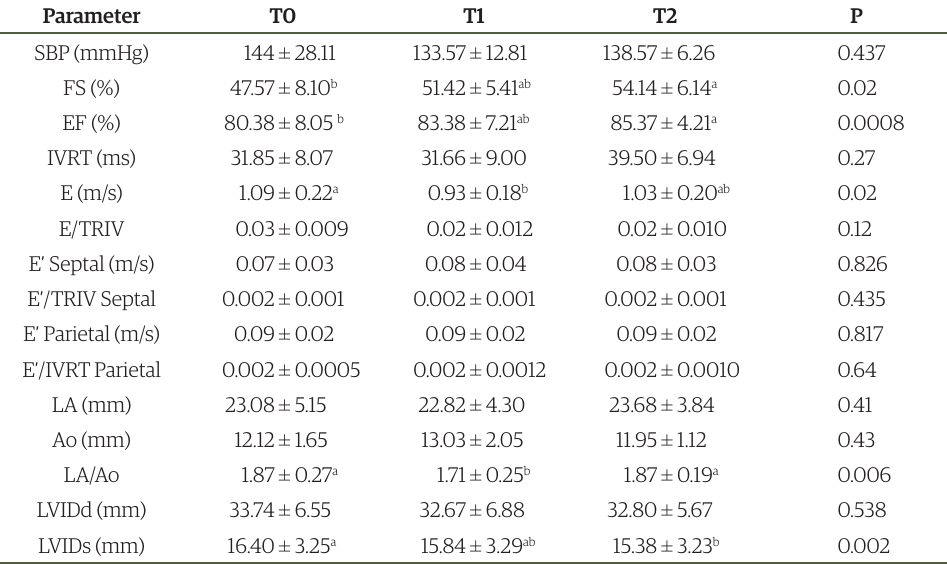
Table 1. Echocardiographic parameters and systolic blood pressure obtained in dogs (n=8) with stage C mitral valve disease at the beginning of treatment (T0), before (T1) and 30 days after (T2) initiation of therapy with metoprolol.